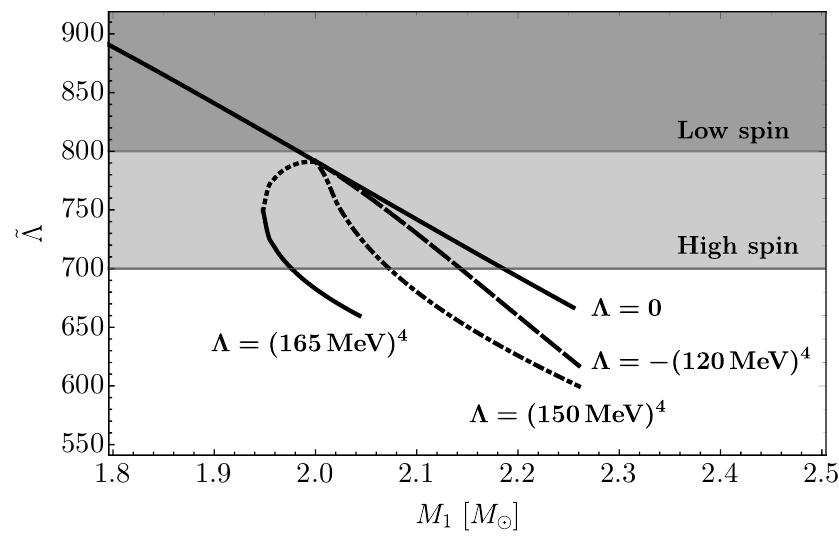
Figure 10. Combined tidal deformability ~ (cid:3) as a function of the heavy star mass M 1 for the Hebeler et al. parametrization with (cid:11) = 3. The chirp mass is the same as in the event GW170817. The (cid:12)gure shows the upper bounds set by the LIGO/Virgo analysis and demonstrates how a nonzero value of (cid:3) can a(cid:11)ect the allowed mass